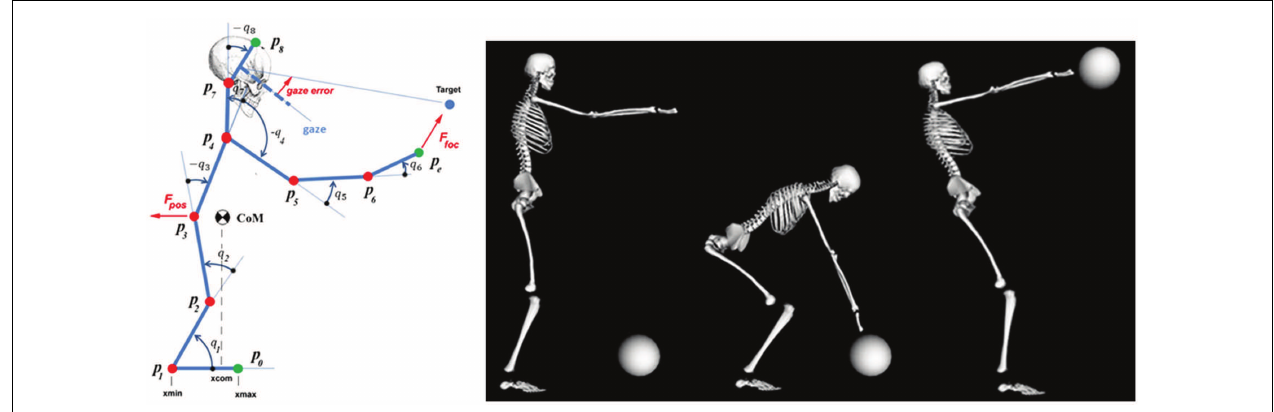
FIGURE 3 |Animation of the body schema for the ball grasp and lift task . Left panel : stick figure related to the simulation. q1: ankle joint; q2: knee joint; q3: hip joint; q4:shoulder joint; q5: elbow joint; q6: wrist joint; q7: neck joint; q8: cervical joint. Right panel : key postures of the reach and lift task.